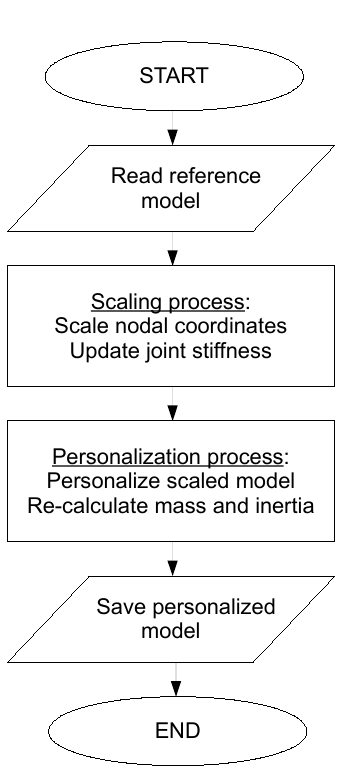
Figure A1. Iteration Process